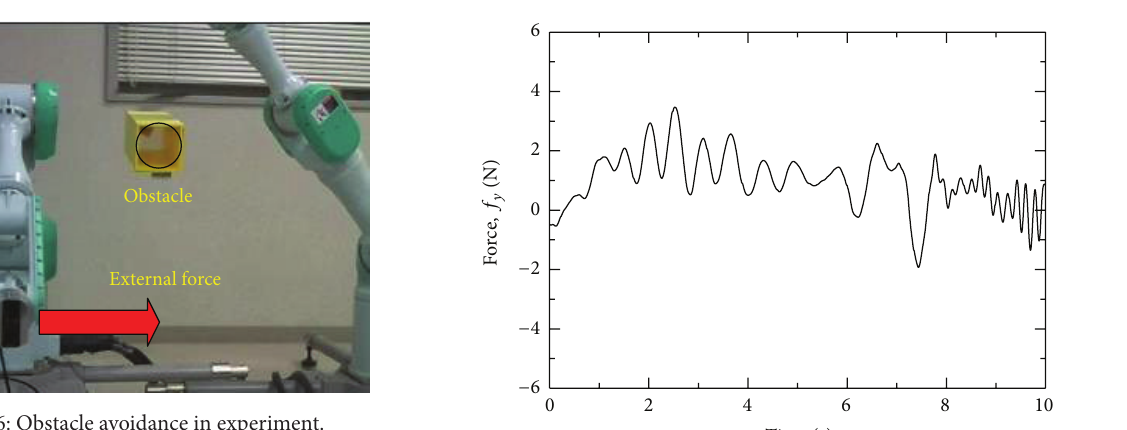
Figure 16: Obstacle avoidance in experiment.